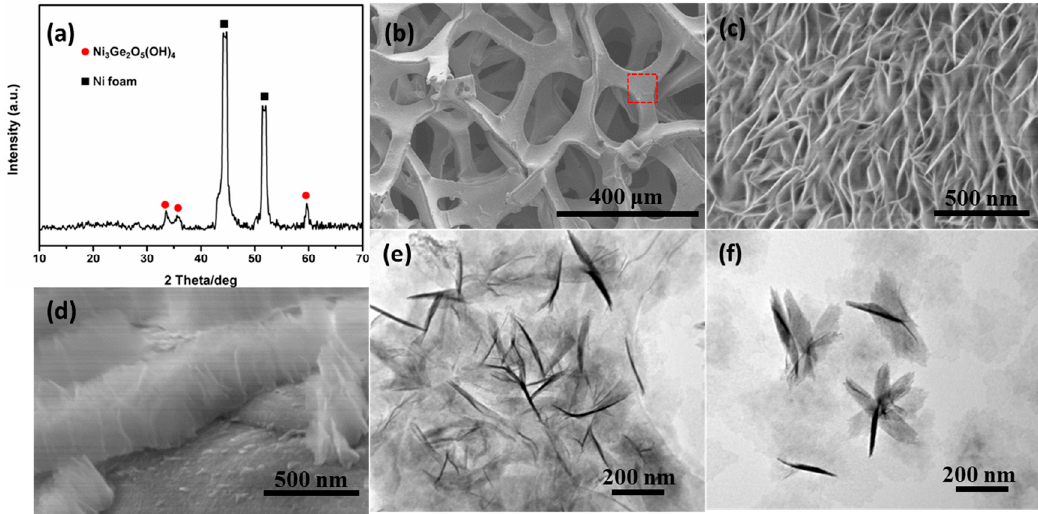
Figure 1. ( a ) X-ray diffraction (XRD) patterns, ( b – d ) scanning electron microscopy (SEM), and ( e , f ) transmission electron microscopy (TEM) images of as-prepared